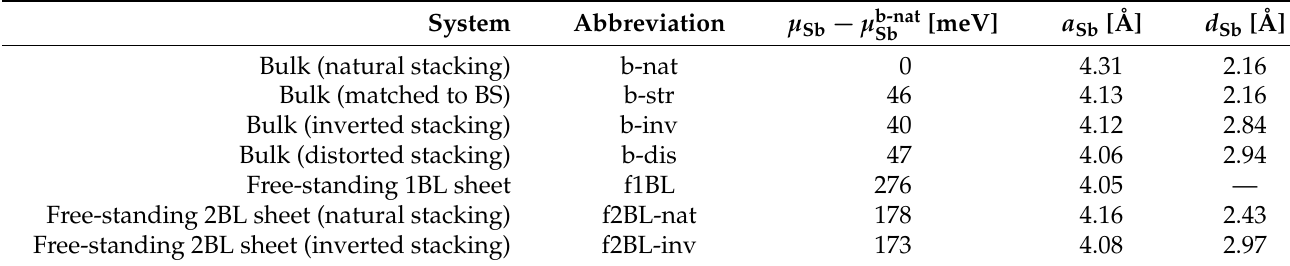
Table 2. Calculated cell parameters for different bulk and layered β -Sb structures: the Sb chemical potential µ Sb (re- ferred to that of bulk β -Sb), the lateral lattice constant a Sb of the hexagonal cell, and the inter-layer distance d Sb between the bilayers